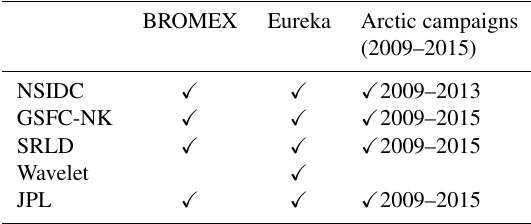
Table 2. Availability of retrieval datasets during this